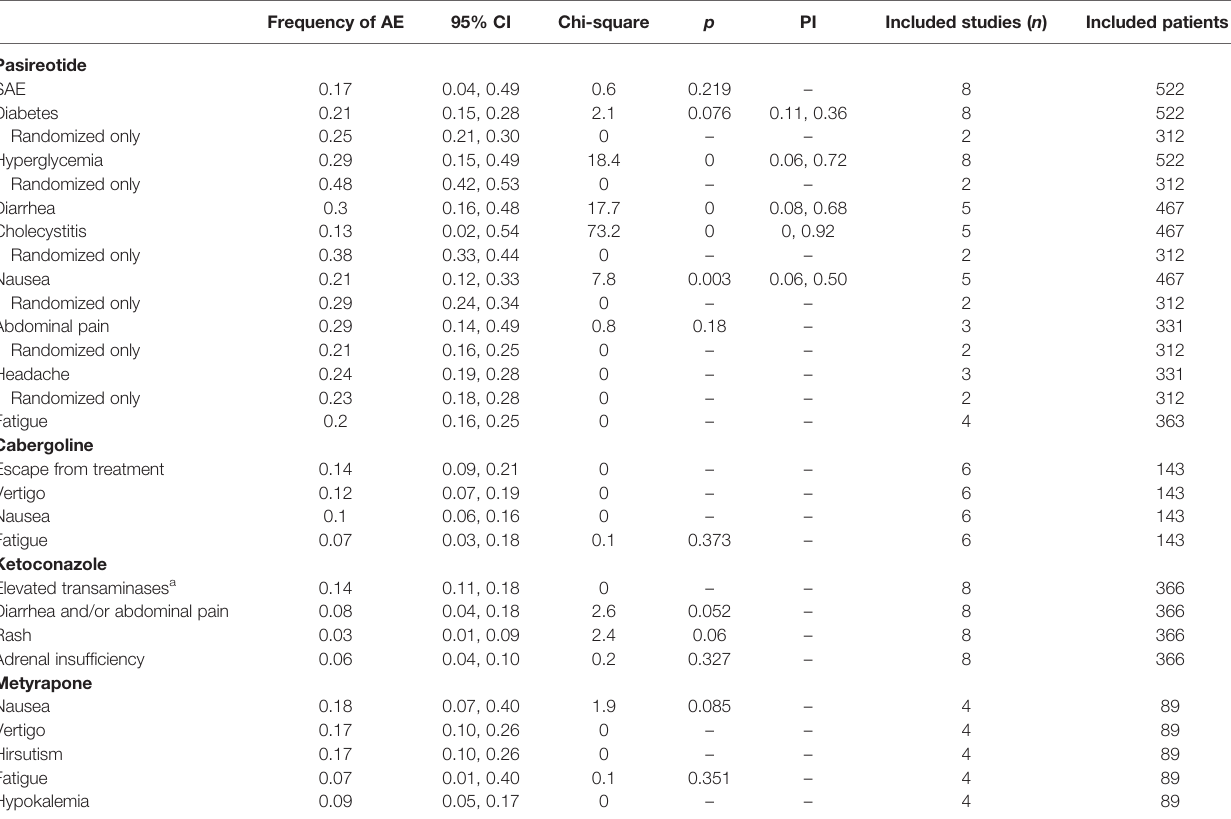
TABLE 4 | Proportional meta-analysis of the frequency of adverse events. Frequency of AE 95% CI